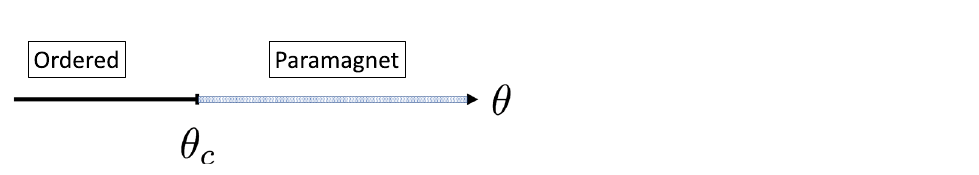
Figure 2. Schematic phase-diagram of the random TIM at T = 0 . The shaded region represents the Griffiths- phase, which extends to the complete paramagnetic